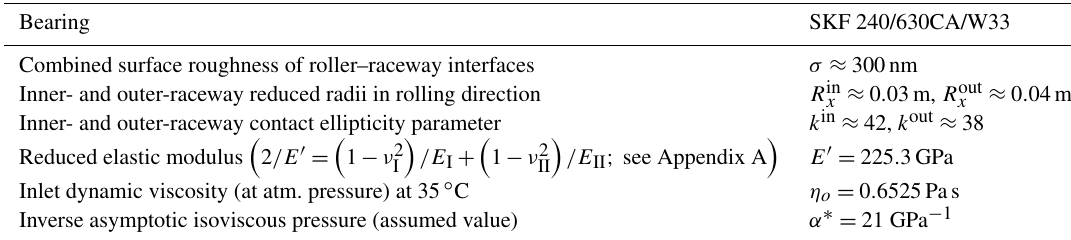
Table 1. Main-bearing and lubricant data. Bearing SKF 240/630CA/W33 Combined surface roughness of roller–raceway interfaces σ ≈ 300nm Inner- and outer-raceway reduced radii in rolling direction R in x ≈ 0 . 03m, R out x ≈ 0 . 04m Inner- and outer-raceway contact ellipticity parameter k in ≈ 42, k out ≈ 38 (cid:16) (cid:16) (cid:17) (cid:16) (cid:17) (cid:17) /E I + /E II ; see Appendix A E (cid:48) = 225 . 3GPa Reduced elastic modulus 2 /E (cid:48) = 1 − ν 2 1 − ν 2 I II Inlet dynamic viscosity (at atm. pressure) at 35 ◦ C η o = 0 . 6525Pas Inverse asymptotic isoviscous pressure (assumed value) α ∗ = 21 GPa −